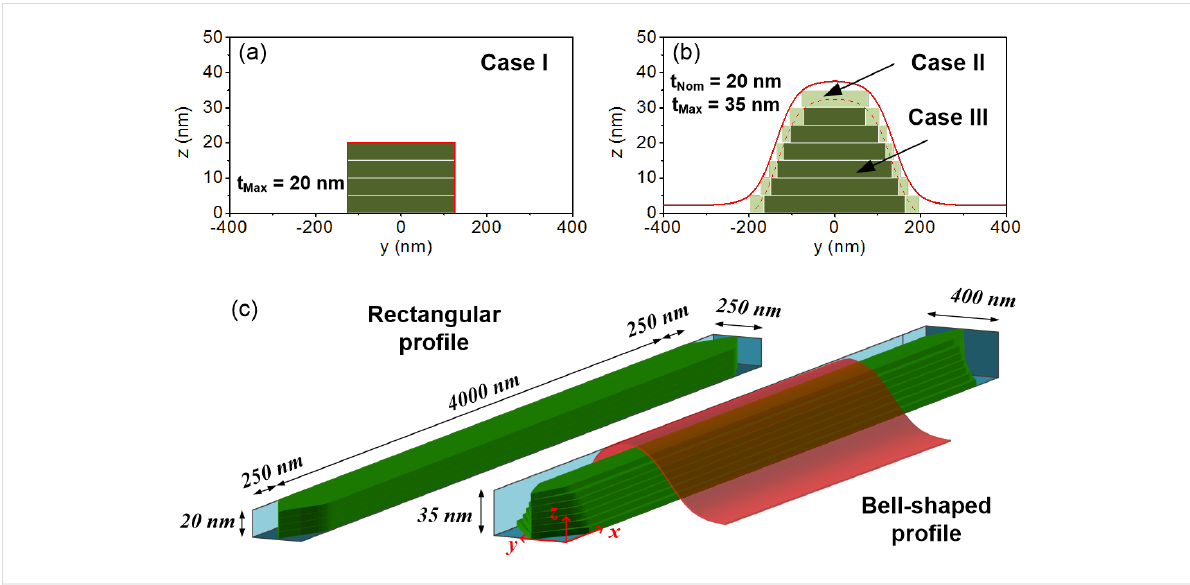
Figure 5: Sketch of the two-dimensional ( y , z plane) geometrical shapes used in the micromagnetic simulation for a 250 nm wide Fe nanowire with a t Nom of 20 nm: (a) Rectangular profile (case I), (b) approximated bell-shaped profiles without (case II) and with (case III) an oxidized surface layer of 5 nm. (c) Three-dimensional representation of the same wire in case I (left) and case II and case III